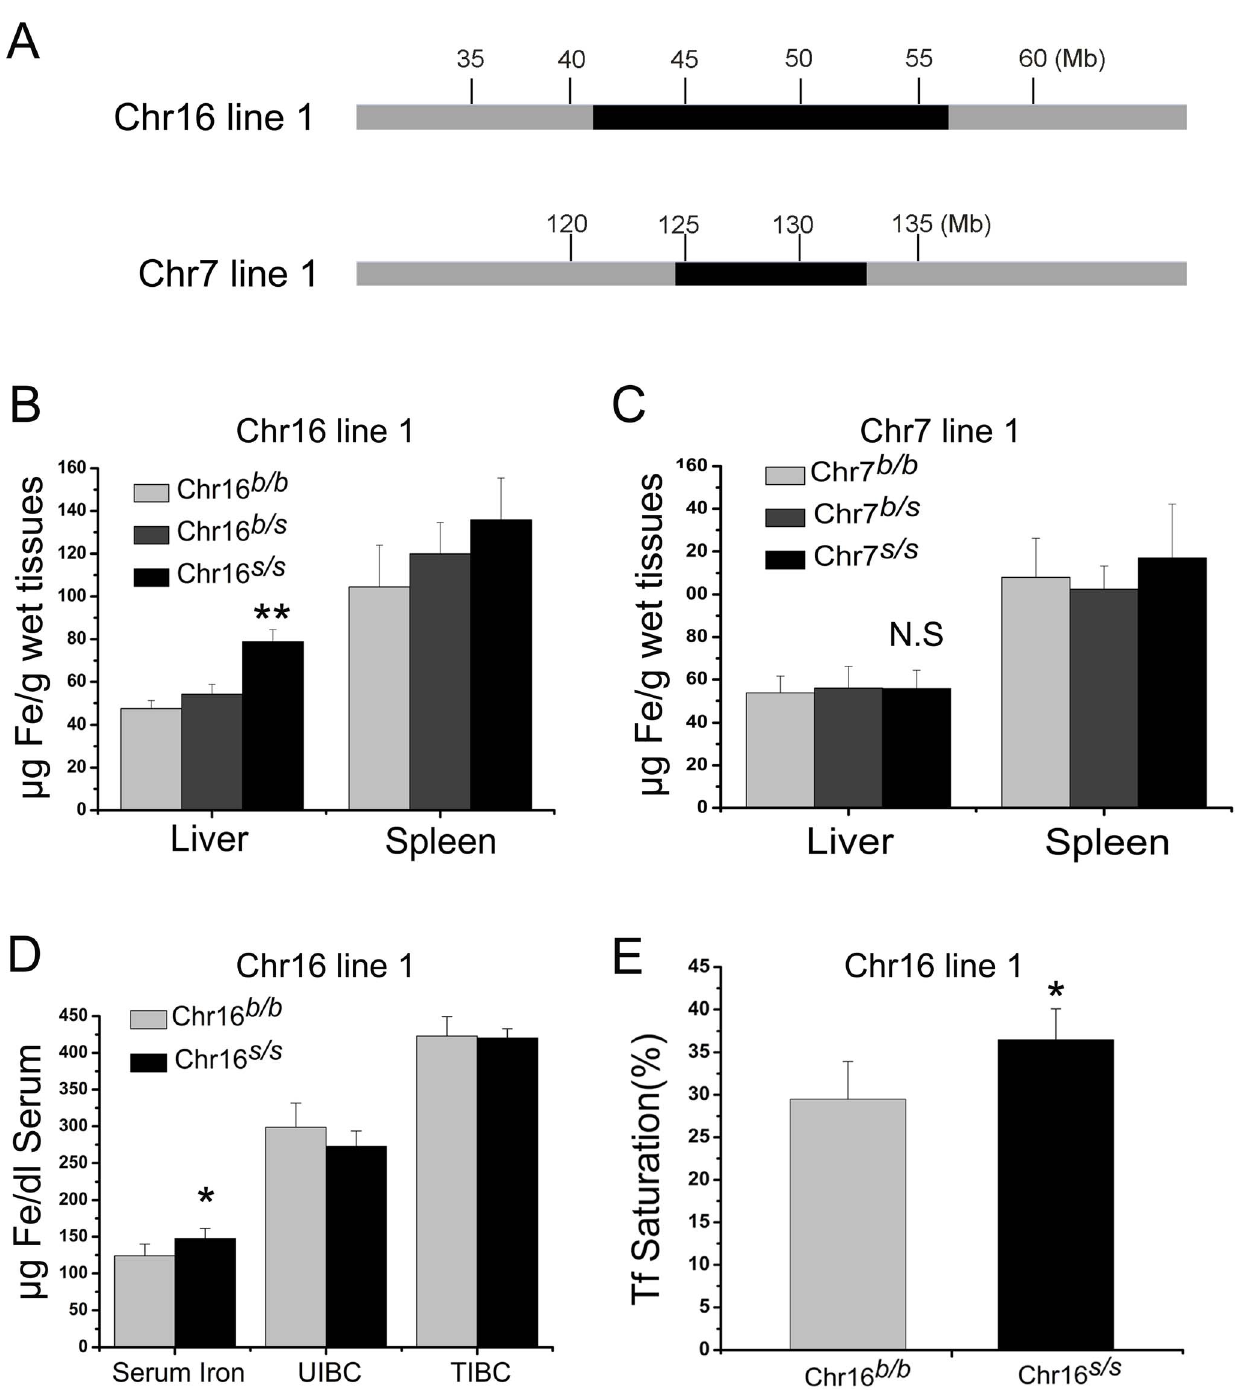
Figure 1. Haplotypes and quantitative measurements of tissue iron in original congenic strains of chromosome 16 and 7. (A) Schematic of original congenic lines carrying portions of SWR chromosomes 7 and 16 (black) on a B6 (grey) background. (B) Liver and spleen non- heme iron concentrations of Chr16 Line 1. (C) Liver and spleen non-heme iron concentrations of congenic lines of Chr7 Line 1. (D) Serum iron, unsaturated iron binding capacity (UIBC) and total iron binding capacity (TIBC), and (E) Serum transferrin saturations (Tf%) measurement of Chr16 Line 1. Data represent mean 6 SEM. N.S: no significance, * P , 0.05, ** P , 0.01. n . 5 for each group. doi:10.1371/journal.pone.0063280.g001 subcongenic lines carrying various SWR chromosome segments Fine mapping of the QTL on Chromosome 16 with between D16Mit125 and D16Mit185 ( Figure 2A ). Six subcon- congenic mice genic lines were developed successfully. We then examined the To fine-map the QTL on Chr16, we continuously backcrossed iron phenotype of these lines. Out of the six congenic lines, three the initial Chr16 congenic line 1 with B6 mice to generate